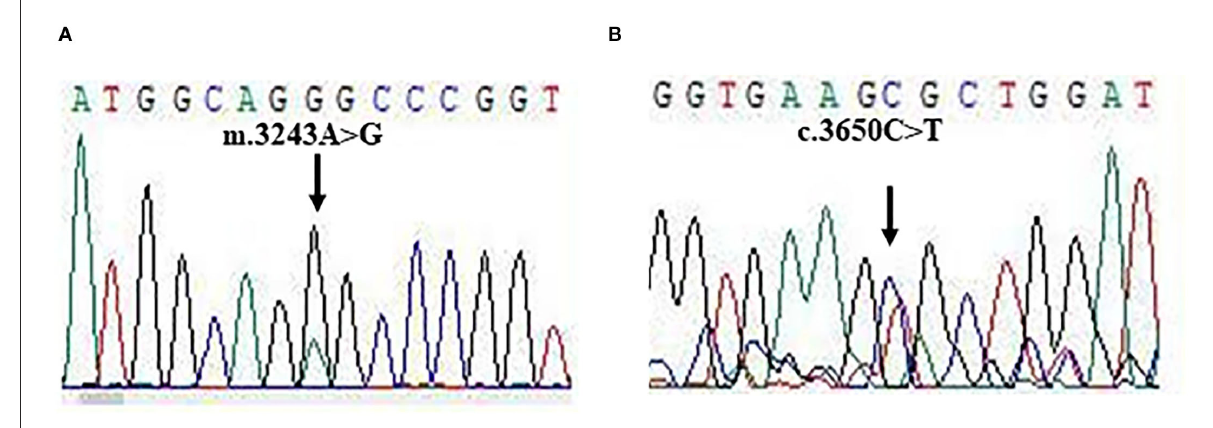
FIGURE3 The gene mutations. (A,B) Sanger sequencing for m.3243A > G and c.3560C > T